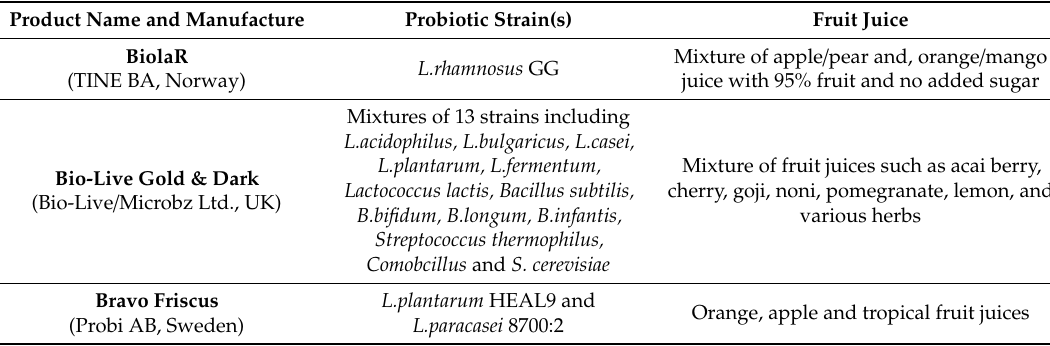
Table 1. Commercially available probiotic juices (references